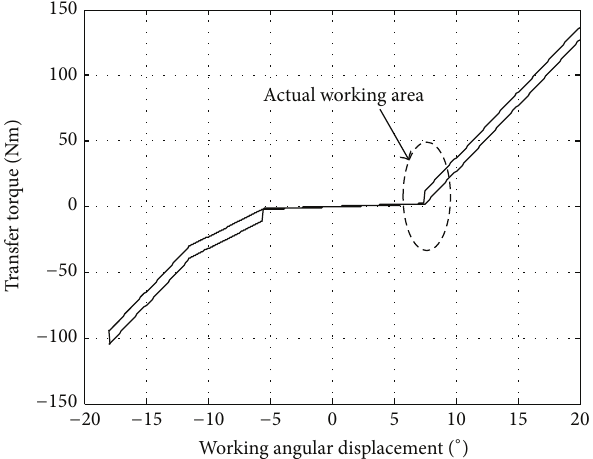
Figure 21: Nonlinear characteristics curve of a two-stage clutch